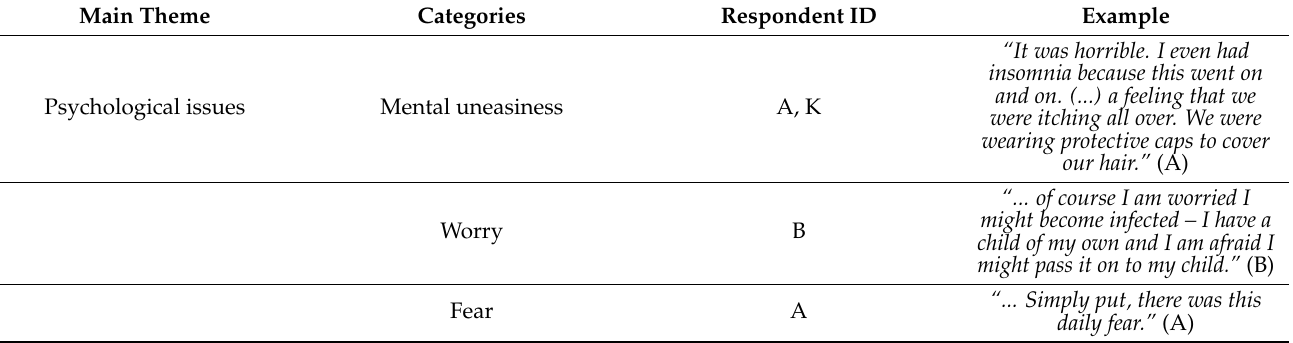
Table 6. Thematic analysis of categories and verbatim quotes for theme four: “ Psychological issues